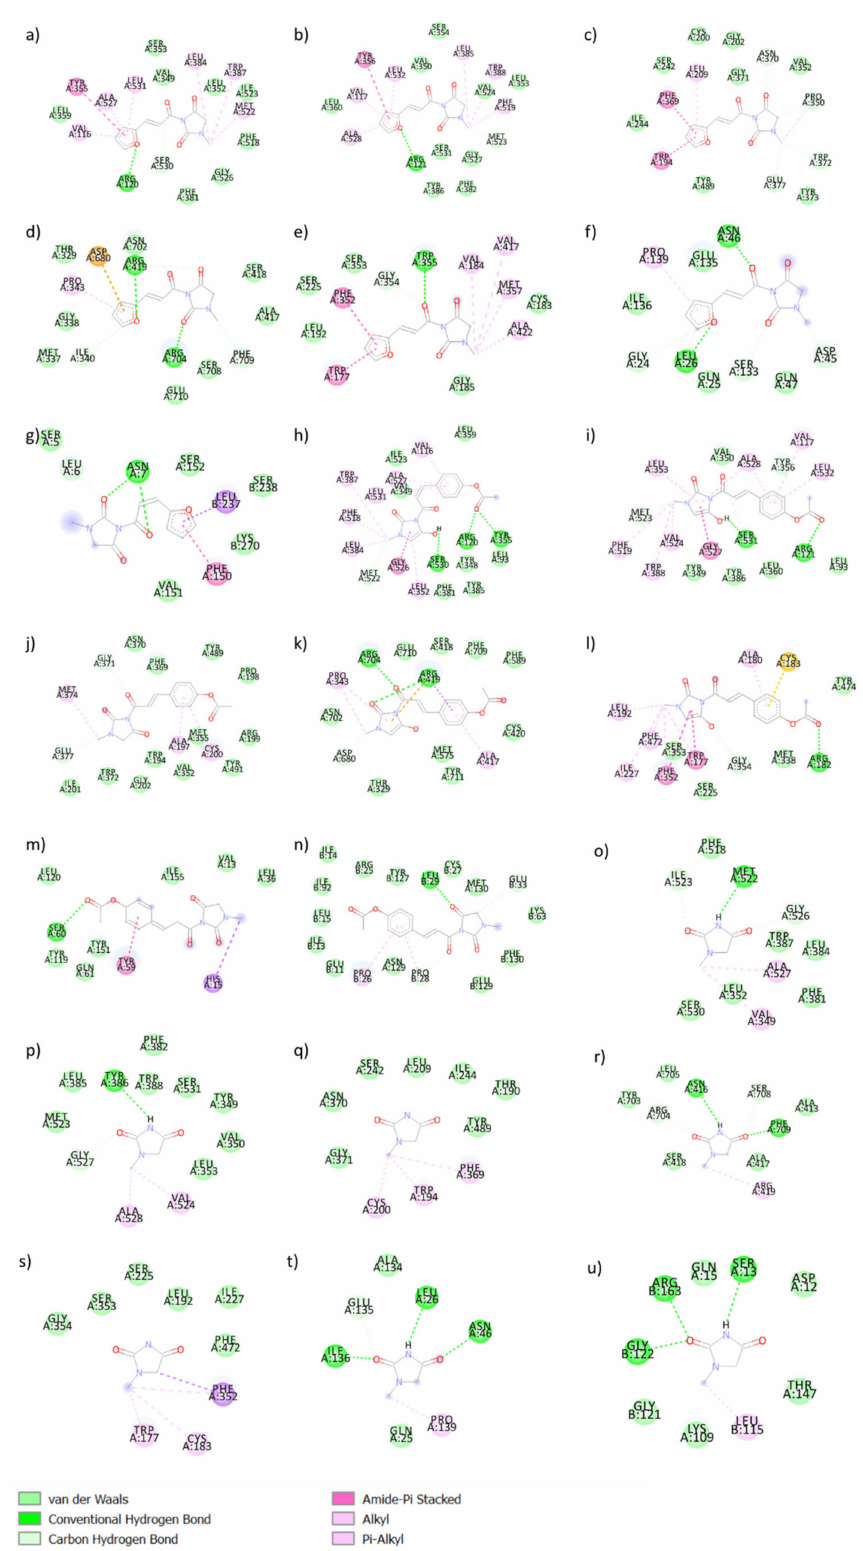
Figure 5. Docking results of compound 2 with COX-1 ( a ), COX-2 ( b ), iNOS ( c ), nNOS ( d ), eNOS ( e ), TNF- α ( f ) and IL-1 β ( g ); compound 4 with COX-1 ( h ), COX-2 ( i ), iNOS ( j ), nNOS ( k ), eNOS ( l ), TNF- α ( m ) and IL-1 β ( n ); and MHD with COX-1 ( o ), COX-2 ( p ), iNOS ( q ), nNOS ( r ), eNOS ( s ), TNF- α ( t ) and IL-1 β ( u